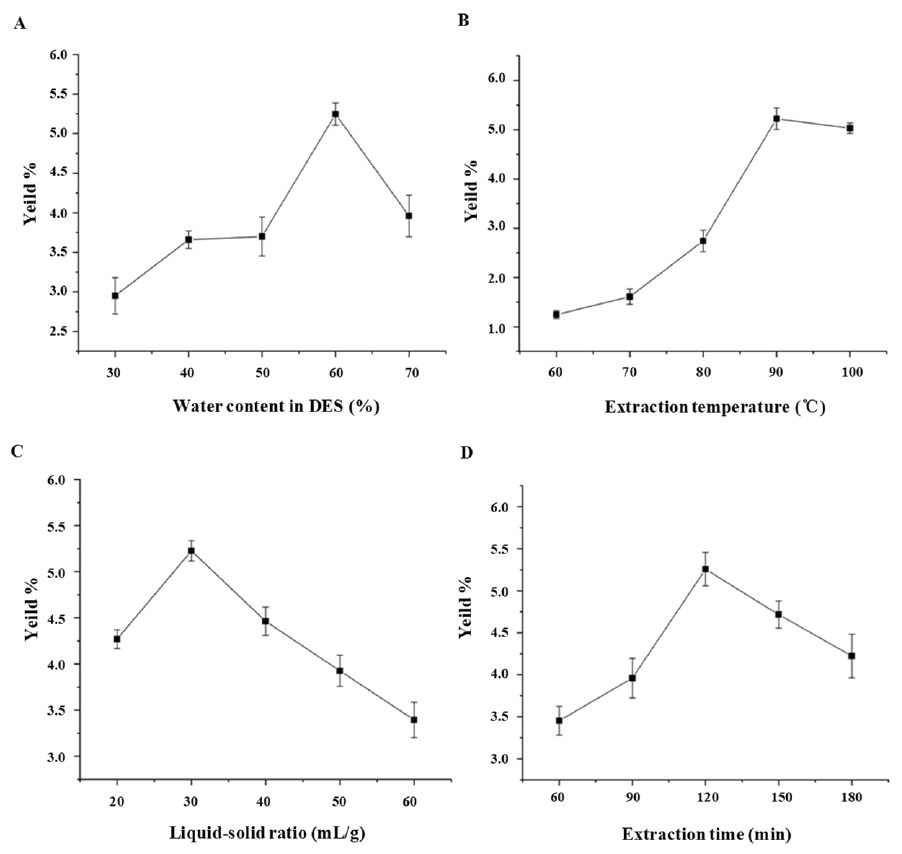
Figure 1. Effects of water content ( A ) in deep eutectic solvent (DES), extraction temperature ( B ), liquid-solid ratio ( C ), and extraction time ( D ) on extraction yields of polysaccharides extracted from lotus leaves.